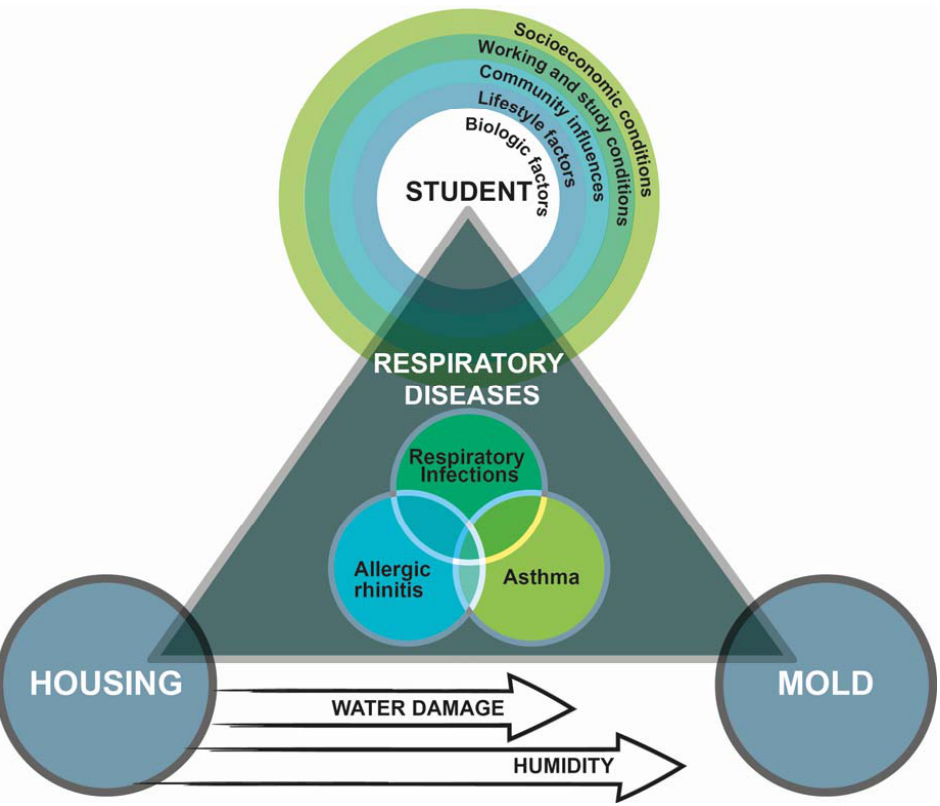
Figure 2. Conceptual model illustrating the impact of mold exposure in student housing on respiratory diseases.